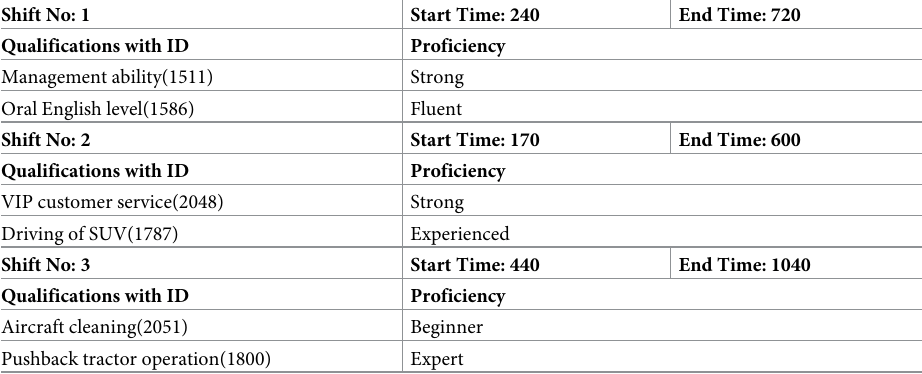
Table 2. Sample shifts with their